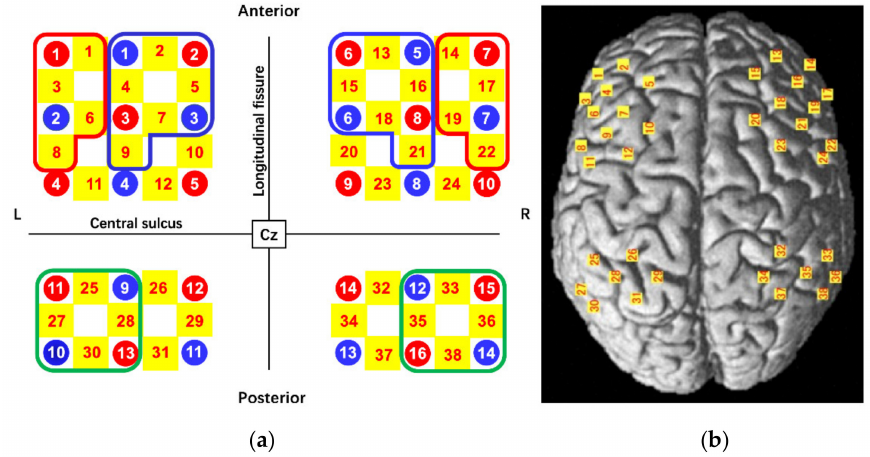
Figure 3. Near-infrared spectroscopy (NIRS) probe arrangement (Left anterior 3 × 3, posterior 3 × 2, Right anterior 3 × 3, posterior 3 × 2). ( a ) Illuminators are shown as red circles; detectors are shown as blue circles; channels are shown with a yellow-highlighted background. The Cz was defined according to the international 10–20 placement system. ( b ) The channel positions are shown on the cortical surface. Red, blue, and green frames show ventrolateral prefrontal cortex (VLPFC), dorsolateral prefrontal cortex (DLPFC) and Inferior parietal cortex (IPC),